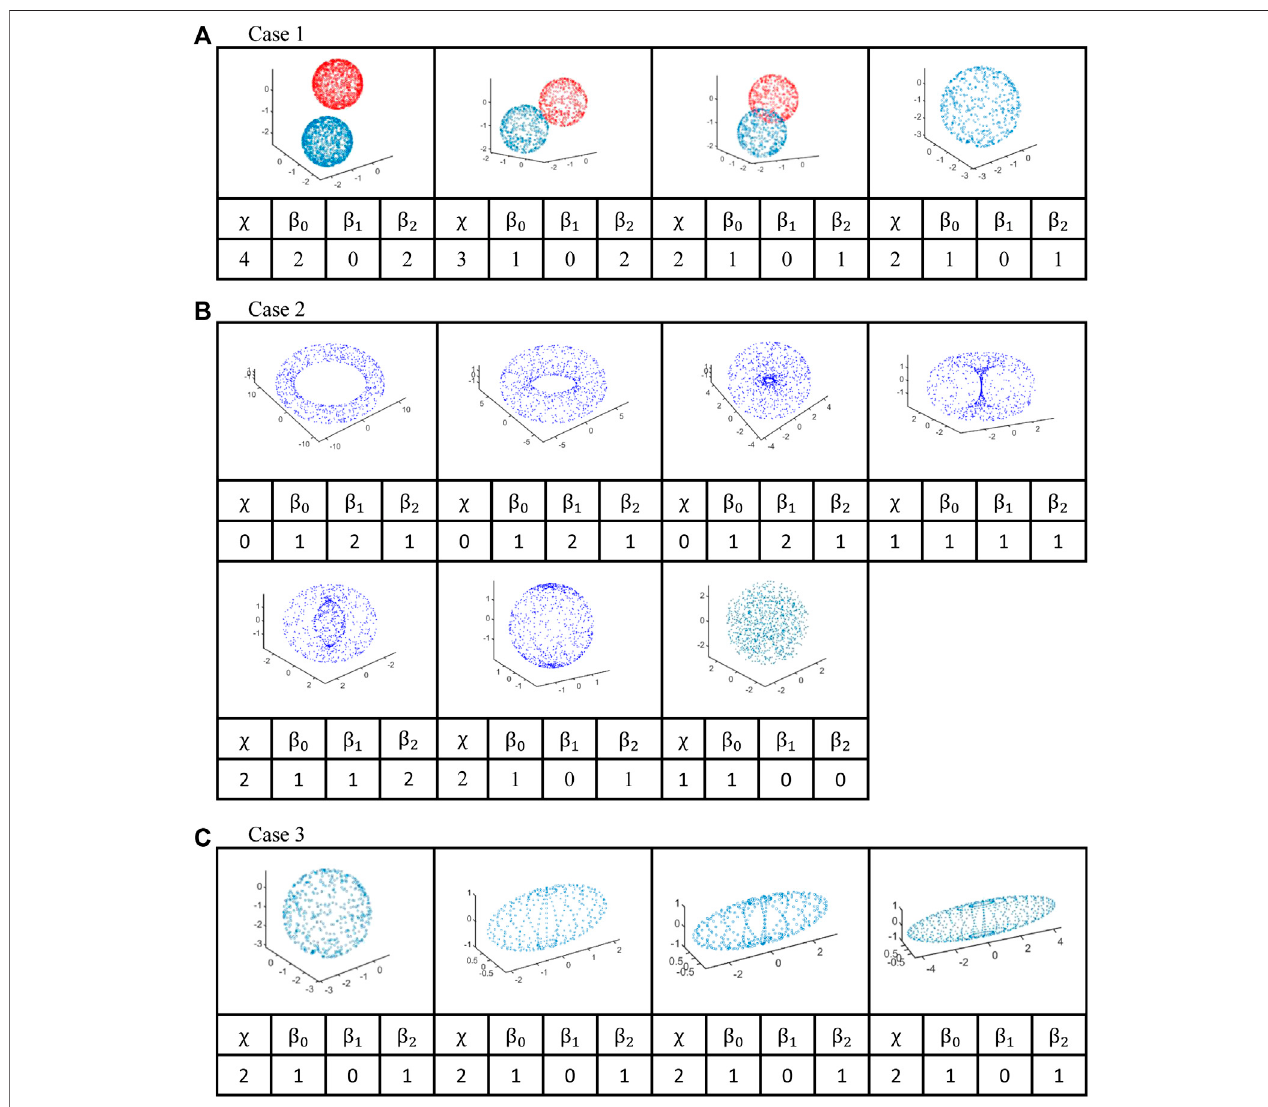
FIGURE6| Thetoy models illustrating three differentsequences oftopologicalchanges. (A) Westartwithtwospherical shells ofradius oneand move them closer untiltheirsurfacestouch,overlap,and fi nallymergedintoalargersinglesphericalshell. (B) Wegenerateasequenceofsurfacesofrevolutionthatstartswithatorus,then one with asmaller hole, then ahorn torus, a spindle torus, and fi nally aspherical shell. We also show asolid sphere. (C) We start with aspherical shell and then deform it into ellipsoids, whose semi-axis we increase from 5 → 10 → 20.